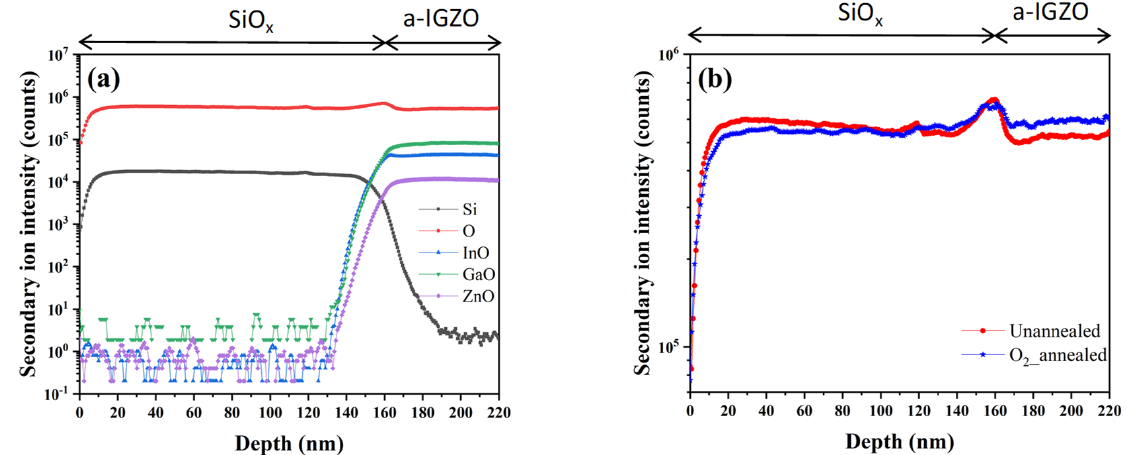
Figure 6. ( a ) SIMS depth profiles for the unannealed sample; ( b ) the oxygen depth distributions for the unannealed sample and the O 2 _annealed sample.